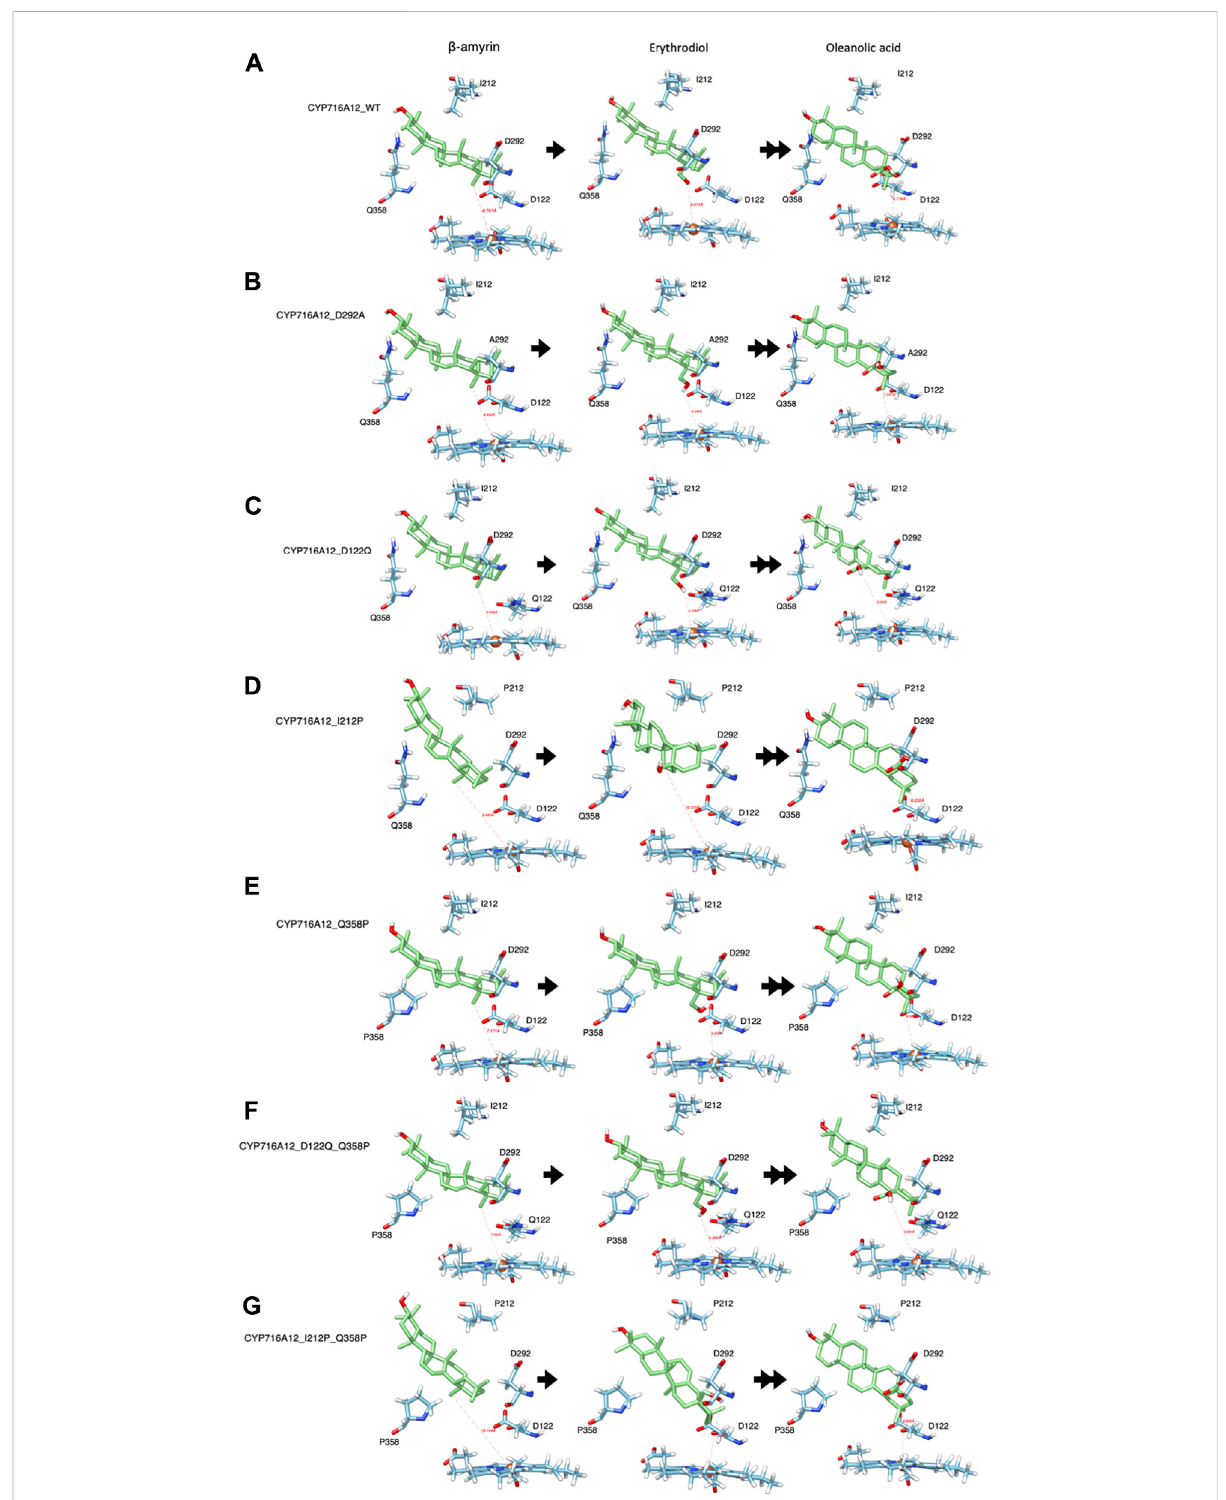
FIGURE 3 Representative interactions of selected CYP716A12 and its variants against the well-known substrate β -amyrin backbone and its derivatives (Erythrodiolandoleanolicacids).Thestructurehomologymodelingshowed β -amyrinbackboneanditsderivativesinwildtypeof (A) CYP716A12,and CYP716A12 variant (B) CYP716A12_D292A, (C) CYP716A12 _D122Q, (D) CYP716A12_I212P, (E) CYP716A12_Q358P, (F) CYP716A12_D122Q_Q358P, and (G)